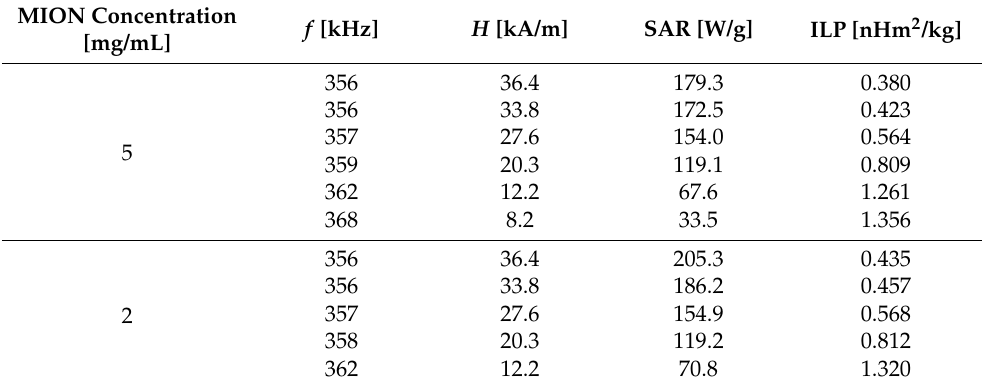
Table 7. SAR and ILP values of the selected